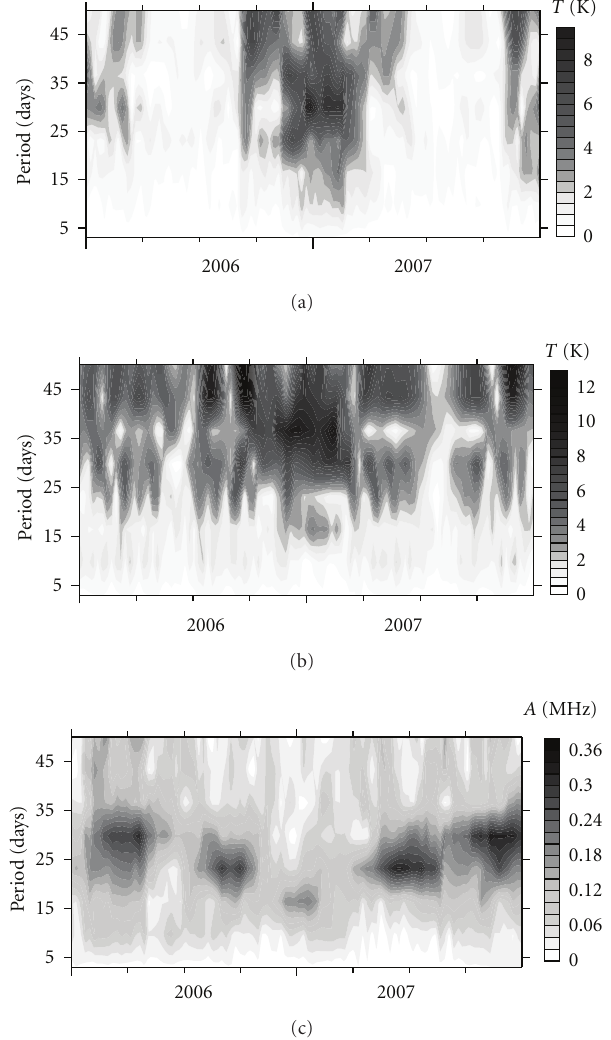
Figure 4: Amplitude spectra, calculated in period range of 5–50 days for stratospheric temperature (a), mesospheric temperature (b), and Δ foF2 (c).